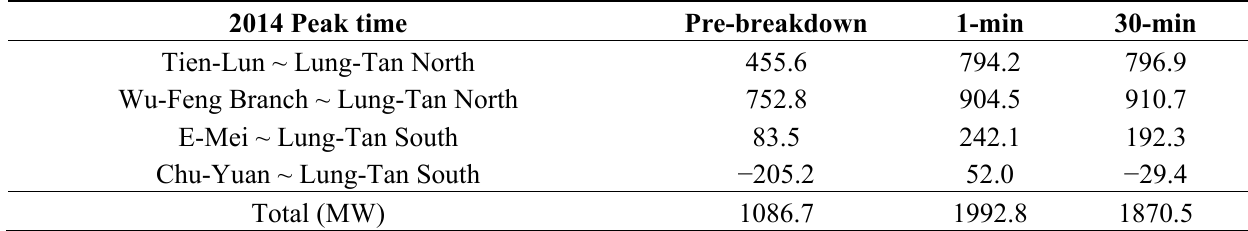
Table 5. Comparison between the central to northern power flow capacities post failure for peak time in